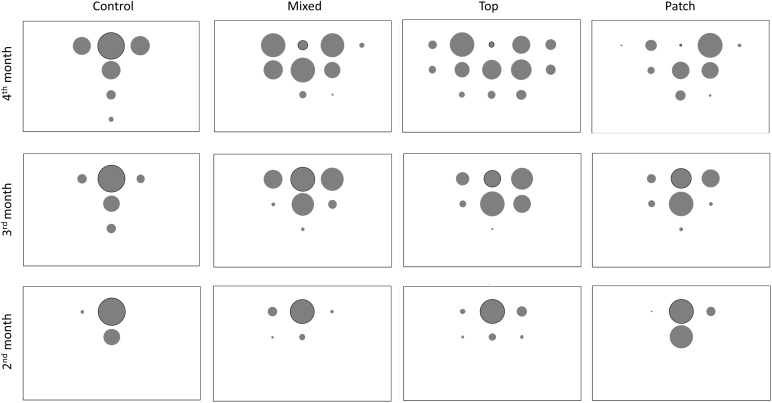
Distribution of new roots in each 20 cm ×20 cm quadrants in each treatment. Bubble size (area) is proportional to the average % of new roots in each quadrant. Outlined bubble indicates the quadrat where the main root was N = 3 except for T where N = 2.